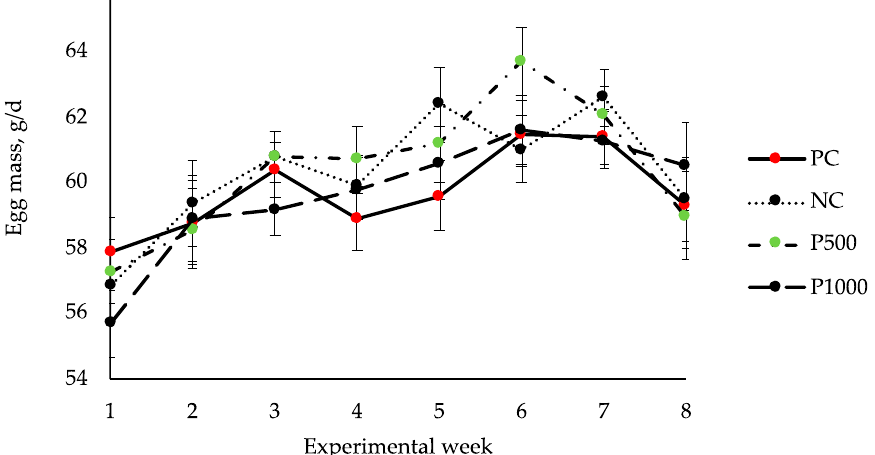
Figure 1. Egg mass evolution over the trial. Treatments: PC, positive control; NC, negative control; P500, NC with 500 FTU/kg of phytase and P1000, NC with 1000 FTU/kg of phytase. p -value of treatment = 0.614, p -value of week < 0.001, p -value of treatment × week = 0.724. Bars represent standard errors.